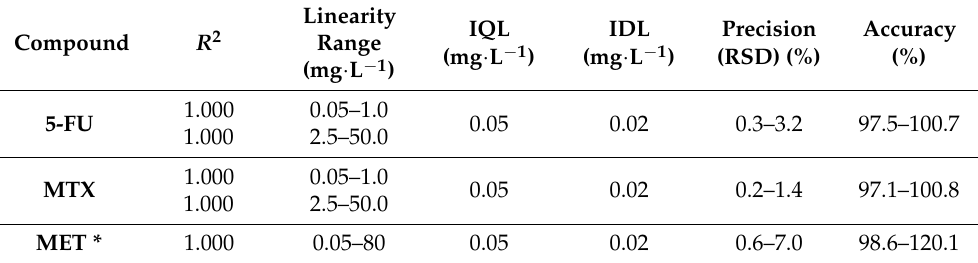
Table 6. Validation parameters of the applied analytical methods using HPLC-UV/Vis.